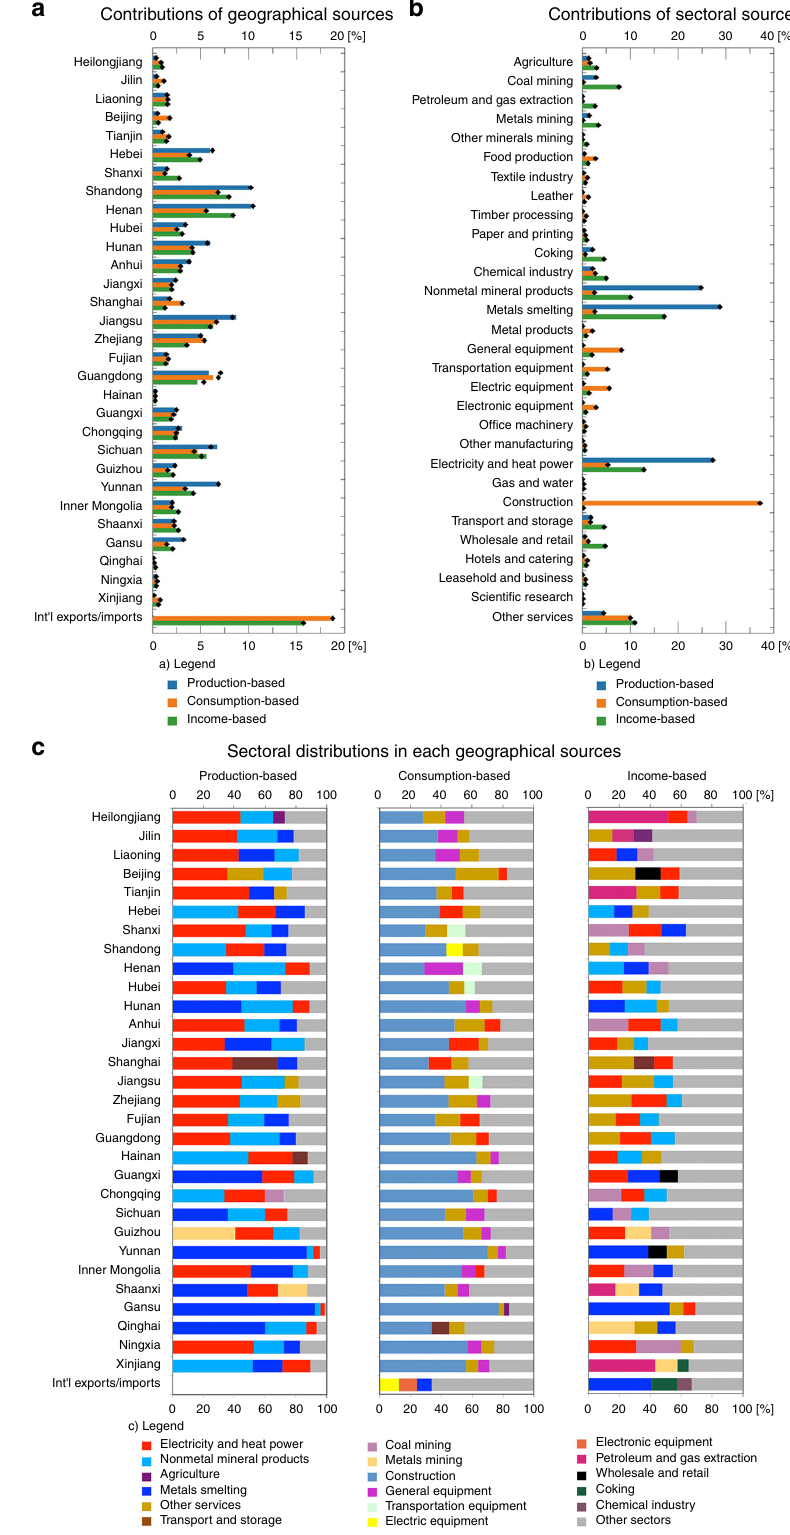
Fig. 2 Contributions of anthropogenic sources to the national attributable per-foetus intelligence quotient (IQ) decrements (0.08 points) and fatal heart attacks (4532 deaths) in China. The attributable IQ decrements and fatal heart attacks refer to these provincial health risks caused by Chinese anthropogenic sources. a , b The results for fatal heart attacks and IQ decrements are shown as coloured bars and black solid diamonds, respectively. c The top three sectors are listed for each geographical source, and the remaining sectors are grouped as other sectors. The results for top sectors are the same for fatal heart attacks and IQ decrements. Int ’ l exports and Int ’ l imports represent international exports and international imports, respectively. The sector names are shorthand versions of the standard names (see Supplementary Table 1). Detailed results for the other sectors in c are shown in Supplementary Data